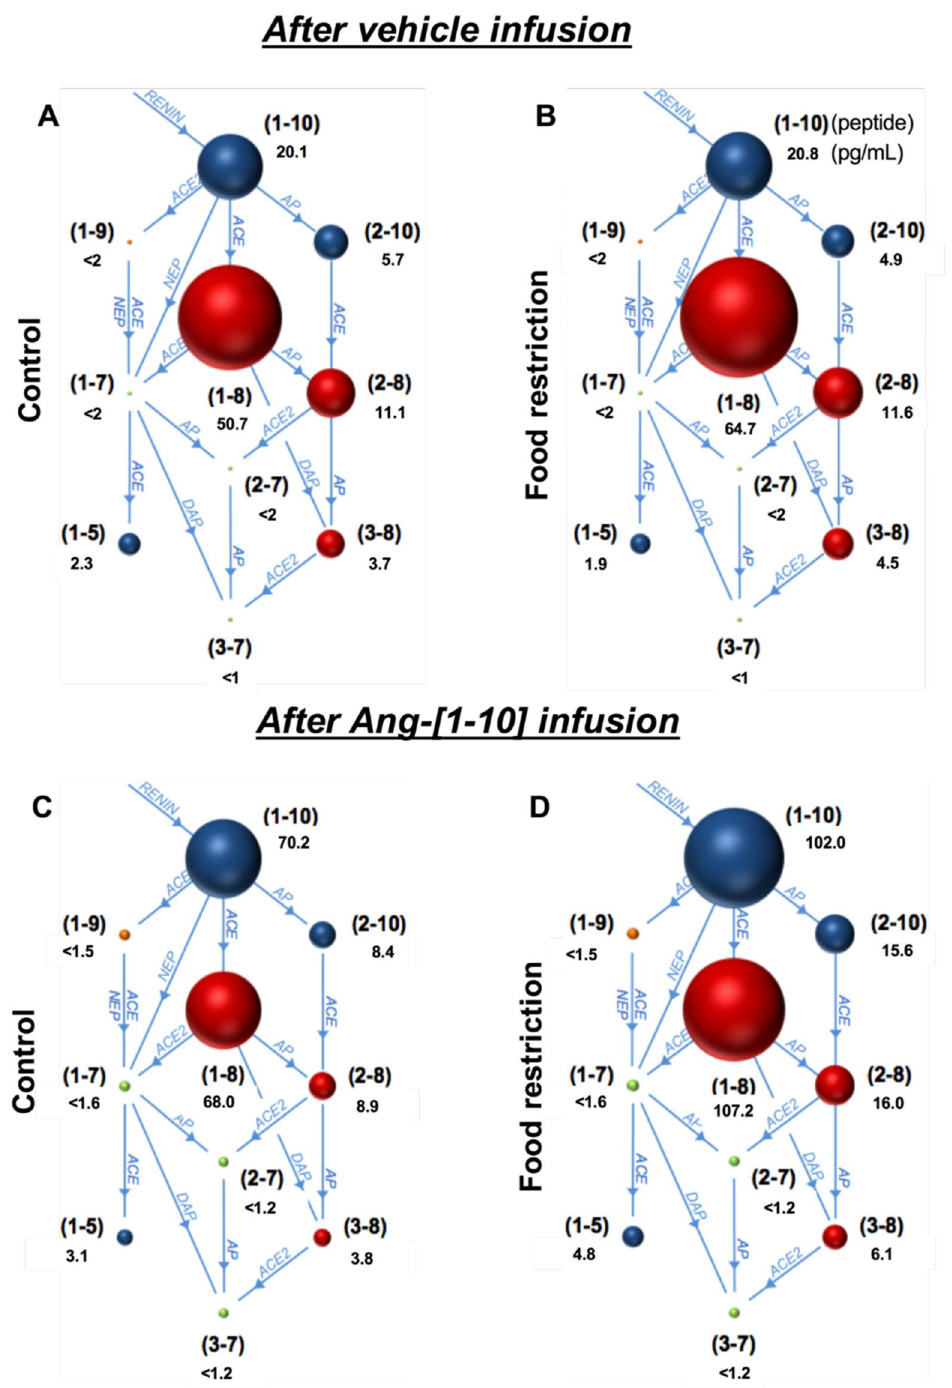
Figure 6. Depiction of the relative effect of FR on plasma angiotensin (Ang) peptides. Shown is the RAS fingerprint of Ang peptides in CT (n = 10) ( A , C ) and FR (n = 11) ( B , D ) female rats before ( A , B ) and after Ang- [1–10] infusion ( C , D ) (n = 8/group). The numbers in parentheses refer to the specific Ang peptide with the peptide concentration (pg/mL) listed below each peptide. For example, (1–10) represents Ang-[1–10]. Red and green circles reflect biologically active and inactive Ang peptides, respectively. The relative amounts of plasma peptides are depicted by the circle volumes, which are drawn to a relative